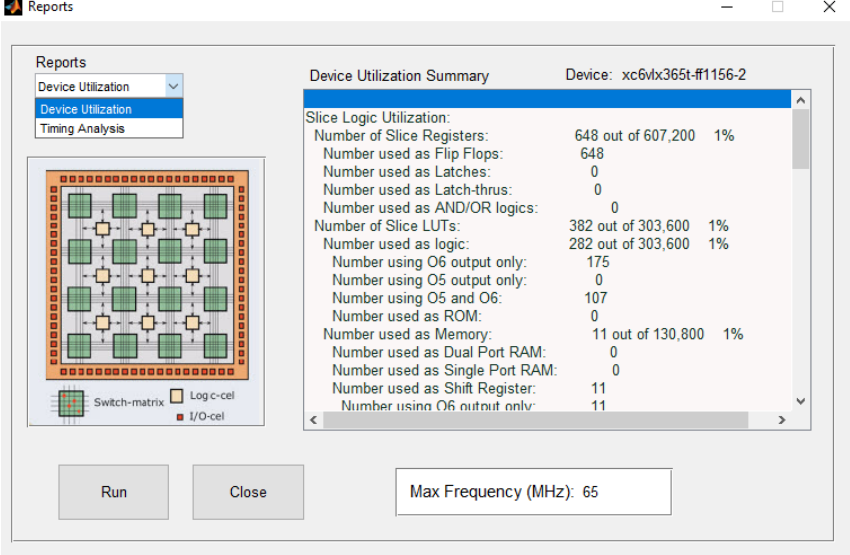
Figure 7. Report analysis option in the software design tool.